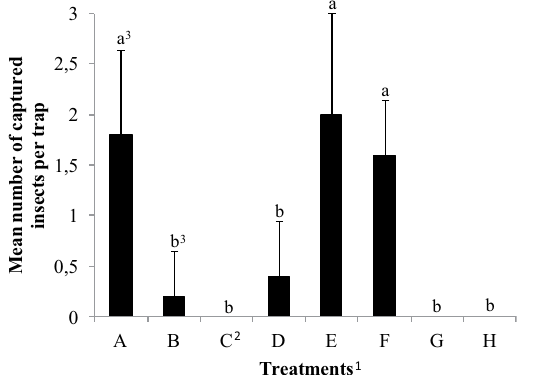
Figure 9. Mean numbers of insects captured in a field experiment testing different treatments, during a period of six days. Treatments: A , cis - 3 ; B , trans - 3 ; C , control; D , cis - 3 + trans - 3 ; E , ( R , R , S )- 3 ; F , 1 + 2 + cis - 3 + 4 ; G , 1 ; H , 2 . 1 A 2 × 5 cm piece of sugarcane was placed inside each trap 2 . The treatment labeled as control used an empty plastic bag as lure 3 . Different letters indicate statistical differences by ANOVA followed by Tukey test (p < 0.01, except for A – D and B – F where p <